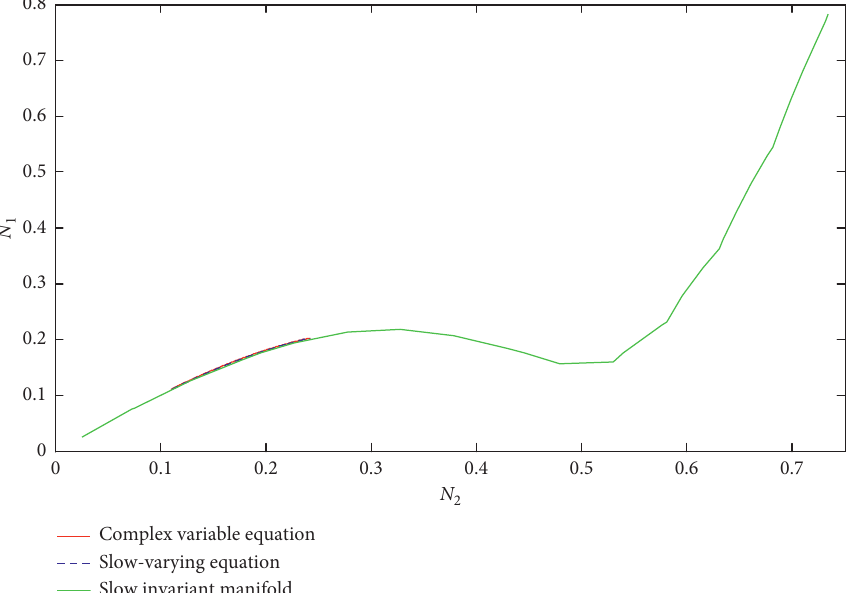
Figure 5: Slow invariant manifold for the case λ